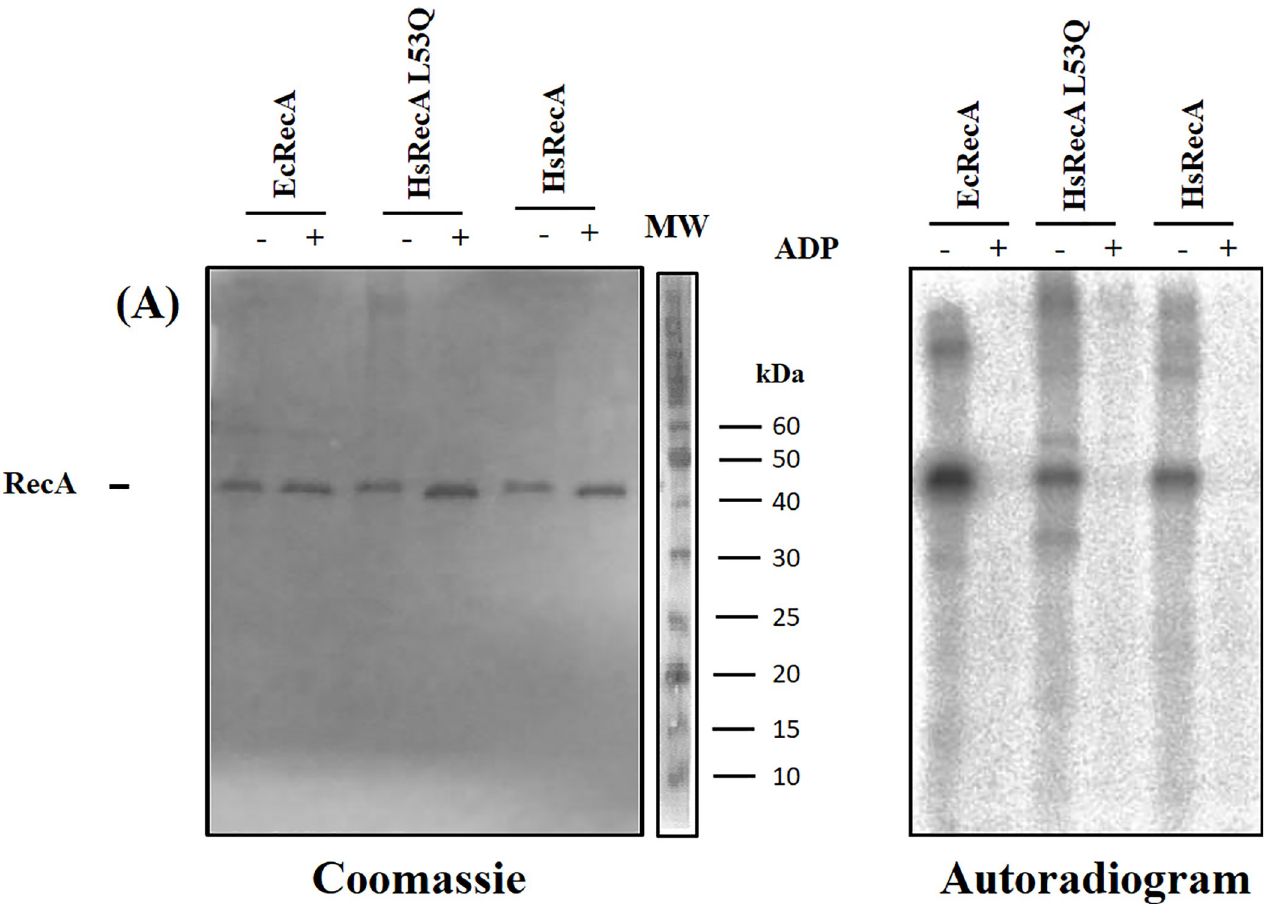
Fig 1. Effect of L53Q substitution in the ATP binding activity of H. seropedicae RecA protein. Legends: - and + indicate absence and presence of ADP, respectively. (A) Coomassie blue-stained SDS-PAGE gel. The separated lane at the right side of Fig 1A shows the molecular weight (MW) markers. (B) Autoradiography of [ α 32 P] ATP-RecA